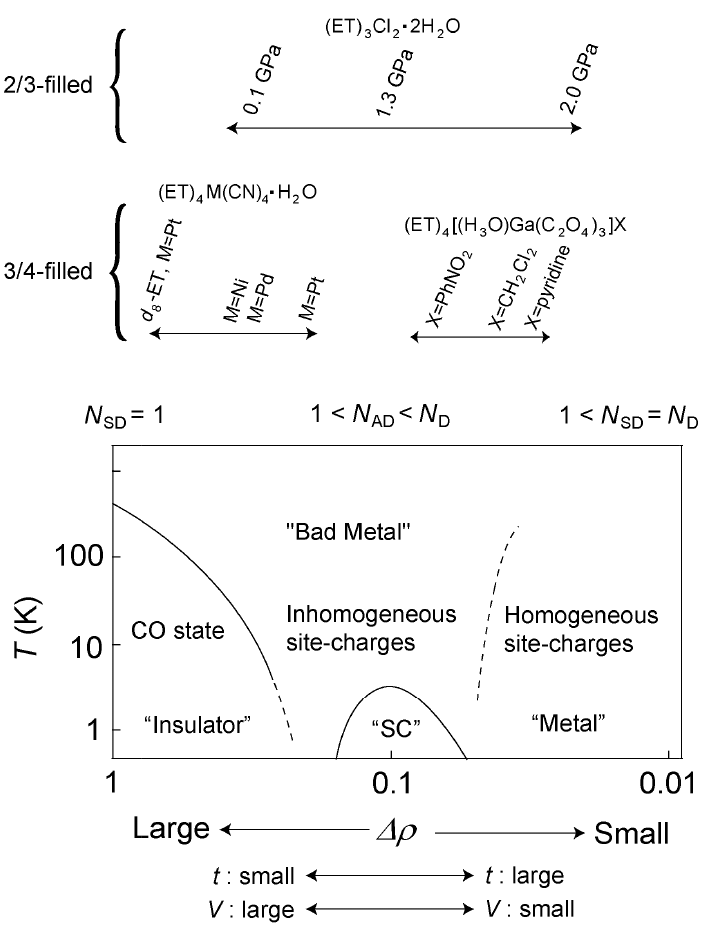
Figure 18. Schematic phase diagram of temperature, T . The transverse axis ionic and neutral-like